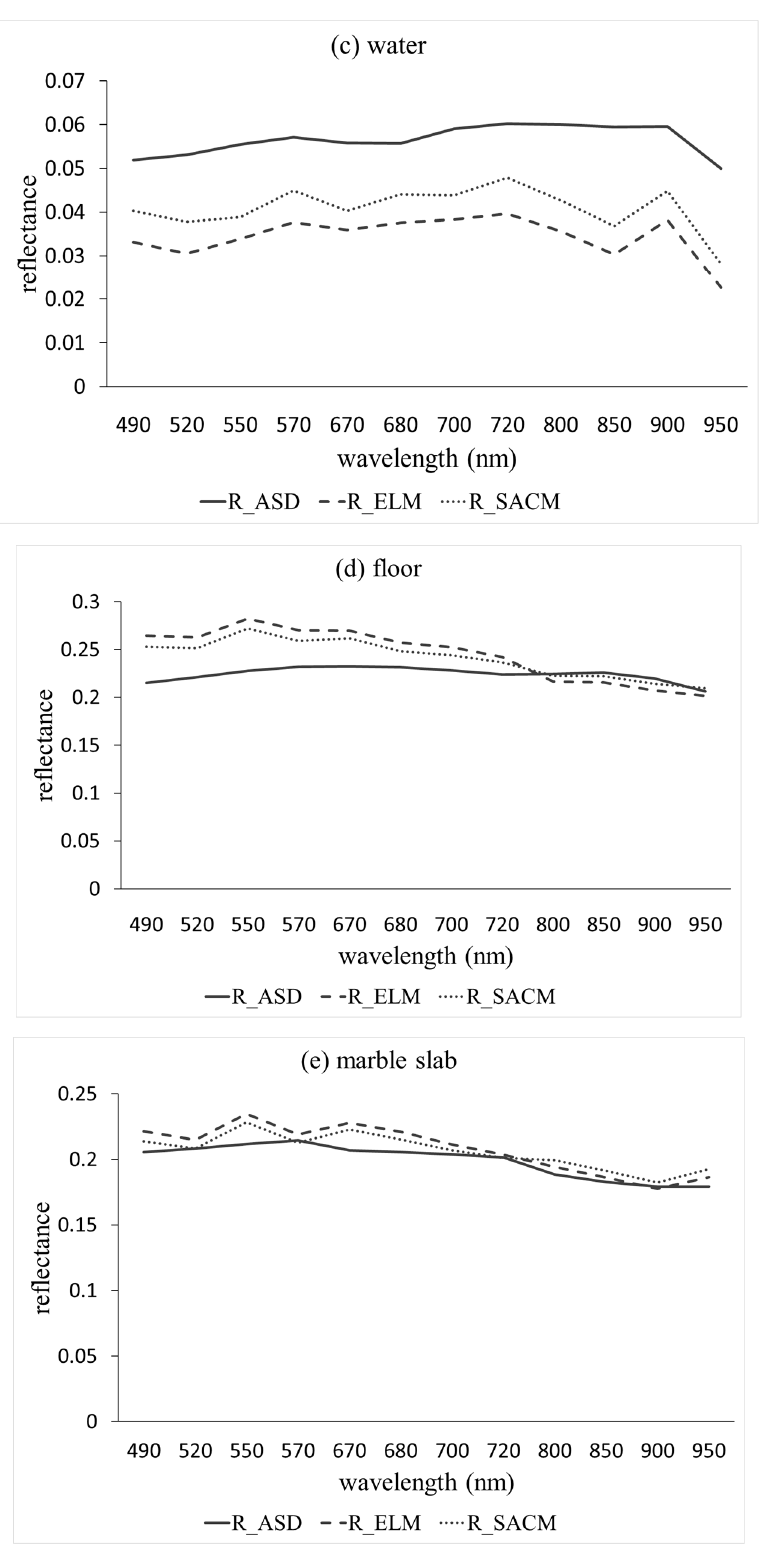
Figure 9. Comparison of ground-measured reflectance and reflectance derived from radiometric calibrated image using ELM and SACM in di ff erent bands for samples of ( a ) vegetation, ( b ) brick, ( c ) water, ( d ) floor, and ( e ) marble slab. R_ASD represents the relectance obtain by spectroradiometer, R_ELM and R_SACM represent the refectance derived by ELM and SACM.